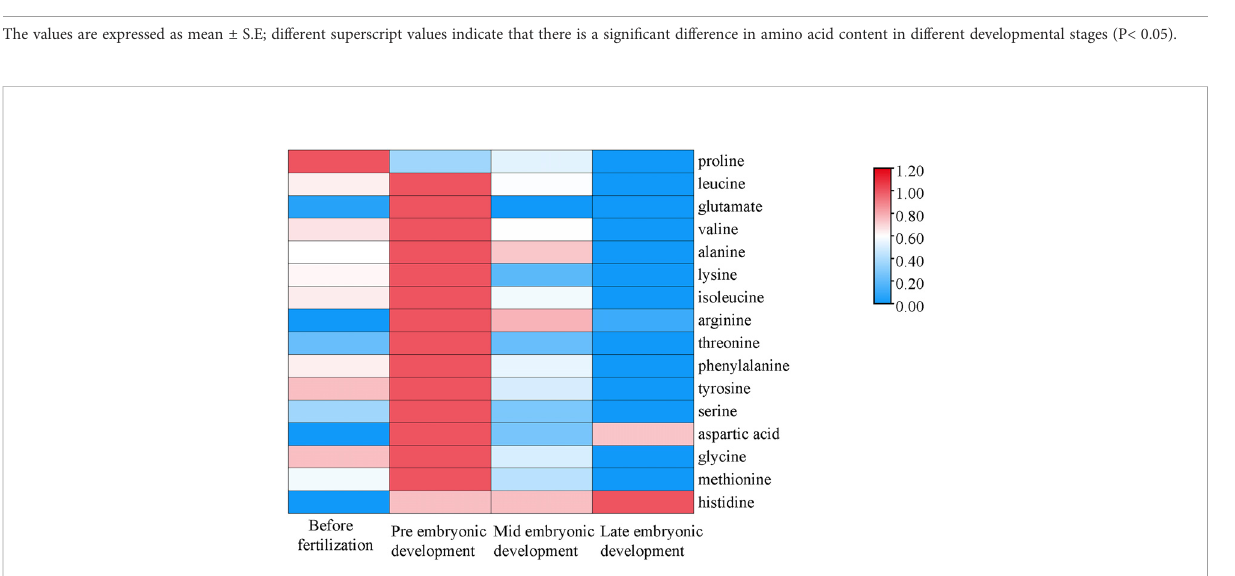
FIGURE 2 Changes in amino acid contents during different developmental stages. The abscissa represents the time sequence of development, respectively before fertilization, pre embryonic development, mid embryonic development and late embryonic development and the ordinate represents the changes in plasma composition of amino acids at different development